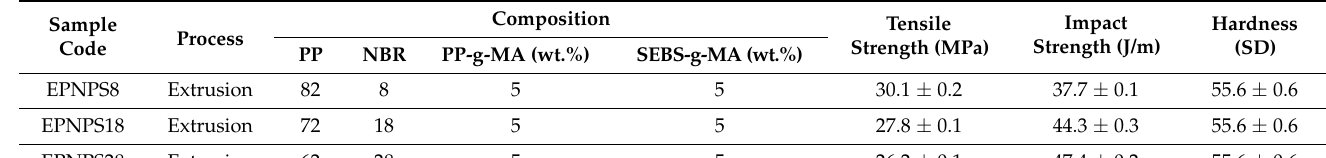
Table 2. Nomenclature and mechanical characteristics of PP/NBR blends.